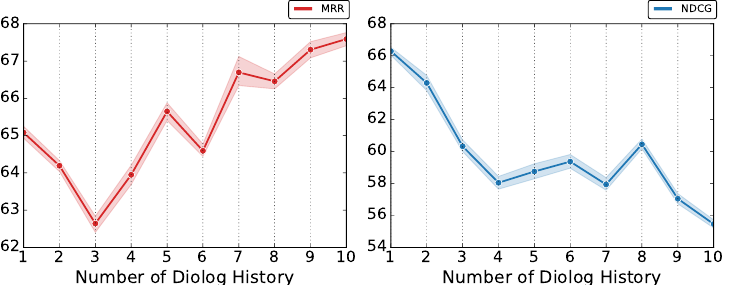
Figure 4. Performance of MVAN with different amounts of dialog history on the VisDial v1.0 validation set.